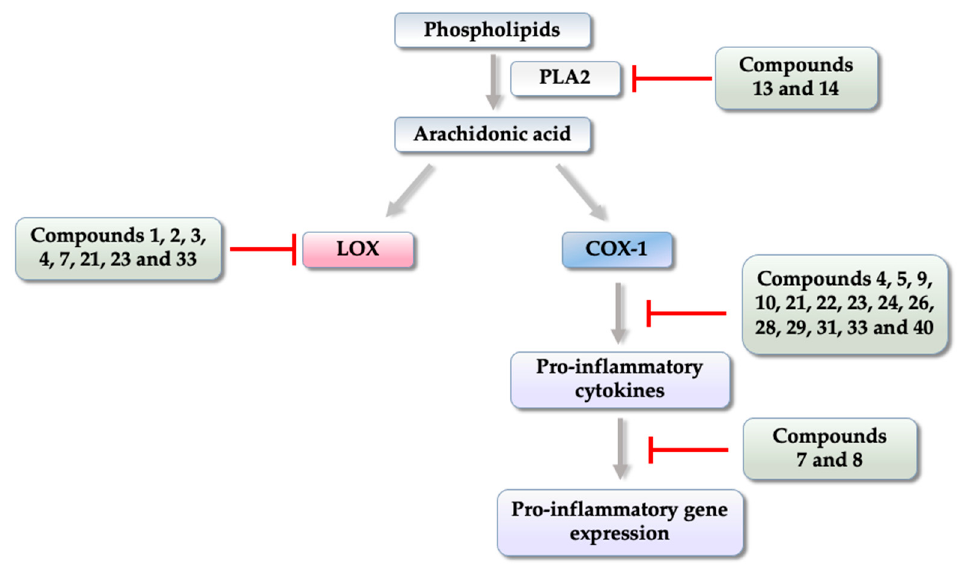
Figure 7. Representative figure of the general mechanisms of action of the thiophene-based com- pounds presented in this review.